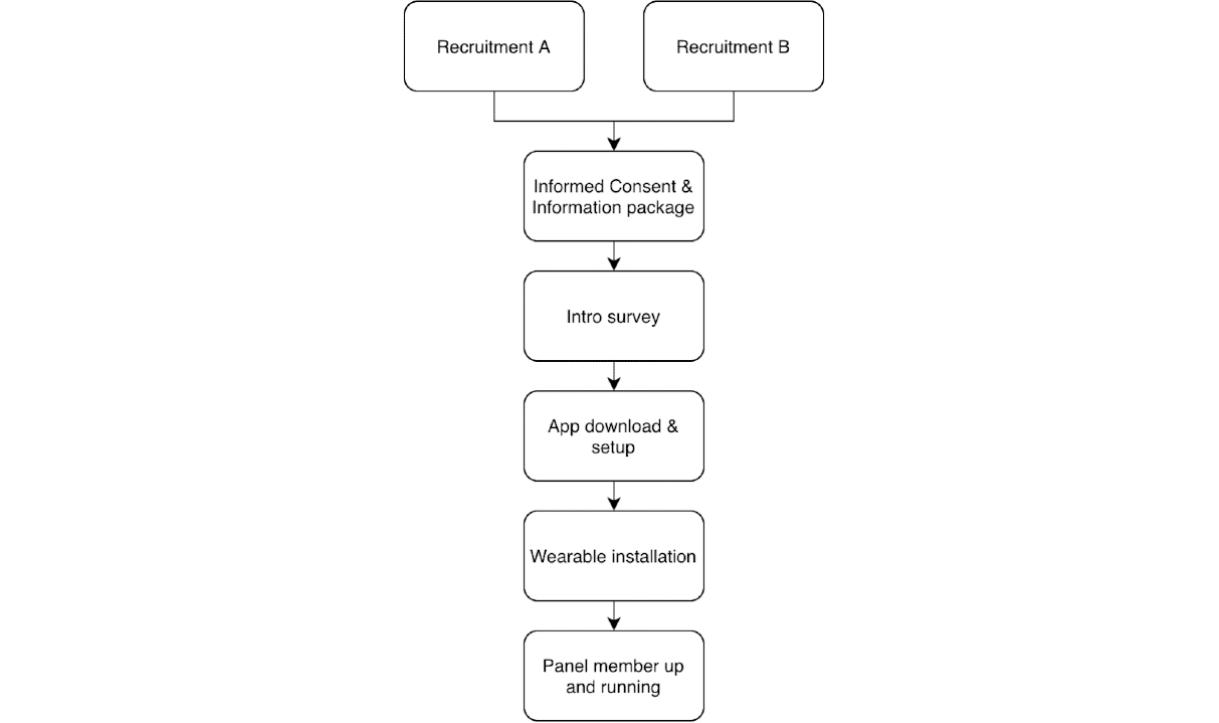
Figure 1. Steps in the enrollment of participants. Starting with recruitment (from different sources), participants receive study information and an informed consent (IC) form and take the introduction survey before downloading and installing the app. After installing the wearable, participants are set up and enrolled in the